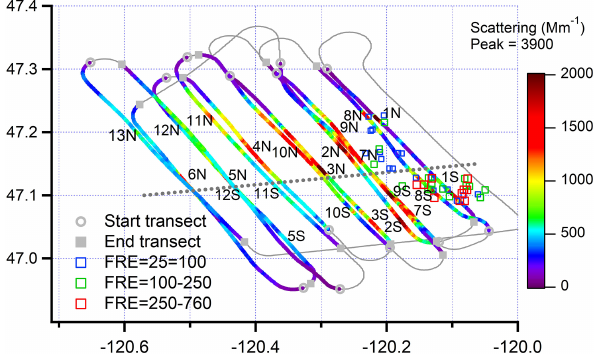
Figure 3. Ground track for flight 730b, colored by light scattering. The Colockum Tarps fire contained two plumes that have different ratios of chloride to total nr-PM1 (see Fig. 5a, following). Tran- sects are labelled 1–13 in consecutive order and, where possible, the northern (low chloride) and southern (high chloride) regions are indicated by a N or S at the point of peak concentration (see Fig. 6, following). A dotted line approximately separates the two regions. MODIS retrievals between 18:00 and 22:00 used for fire radiative energy (FRE). Latitude and longitude not to scale.